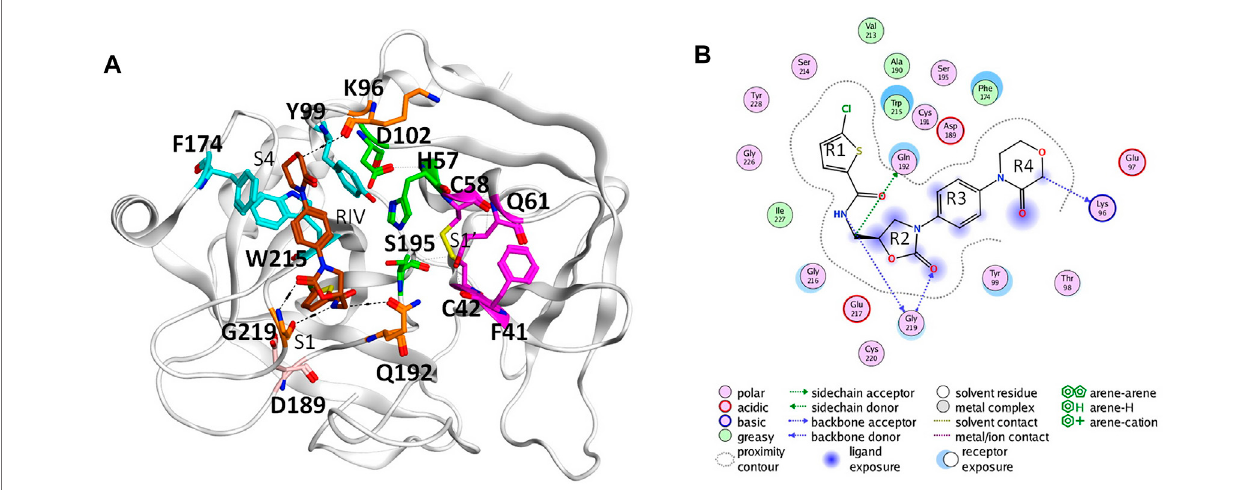
FIGURE 1 | Binding of rivaroxaban (RIV) in the active site of coagulation factor X. (A) Three-dimensional structure from the Protein Data Bank (2W26). The carbon atomsofRIVarecoloredinbrown,whilethoseofthekeyresiduesintheS1pocketandS1 ’ pocketarecoloredinmagentaandthoseofthekeyresiduesintheS4pocket are colored in cyan. Other residues concerning RIV-FX binding are colored in orange, with the catalytic triad in green and D189 in pink. (B) Two-dimensional plot of the binding of RIV with the interactions with the surrounding residues illustrated later. For convenience, the four rings of RIV are named as R1 to R4 from the chlorothiophene moiety to the morpholinone